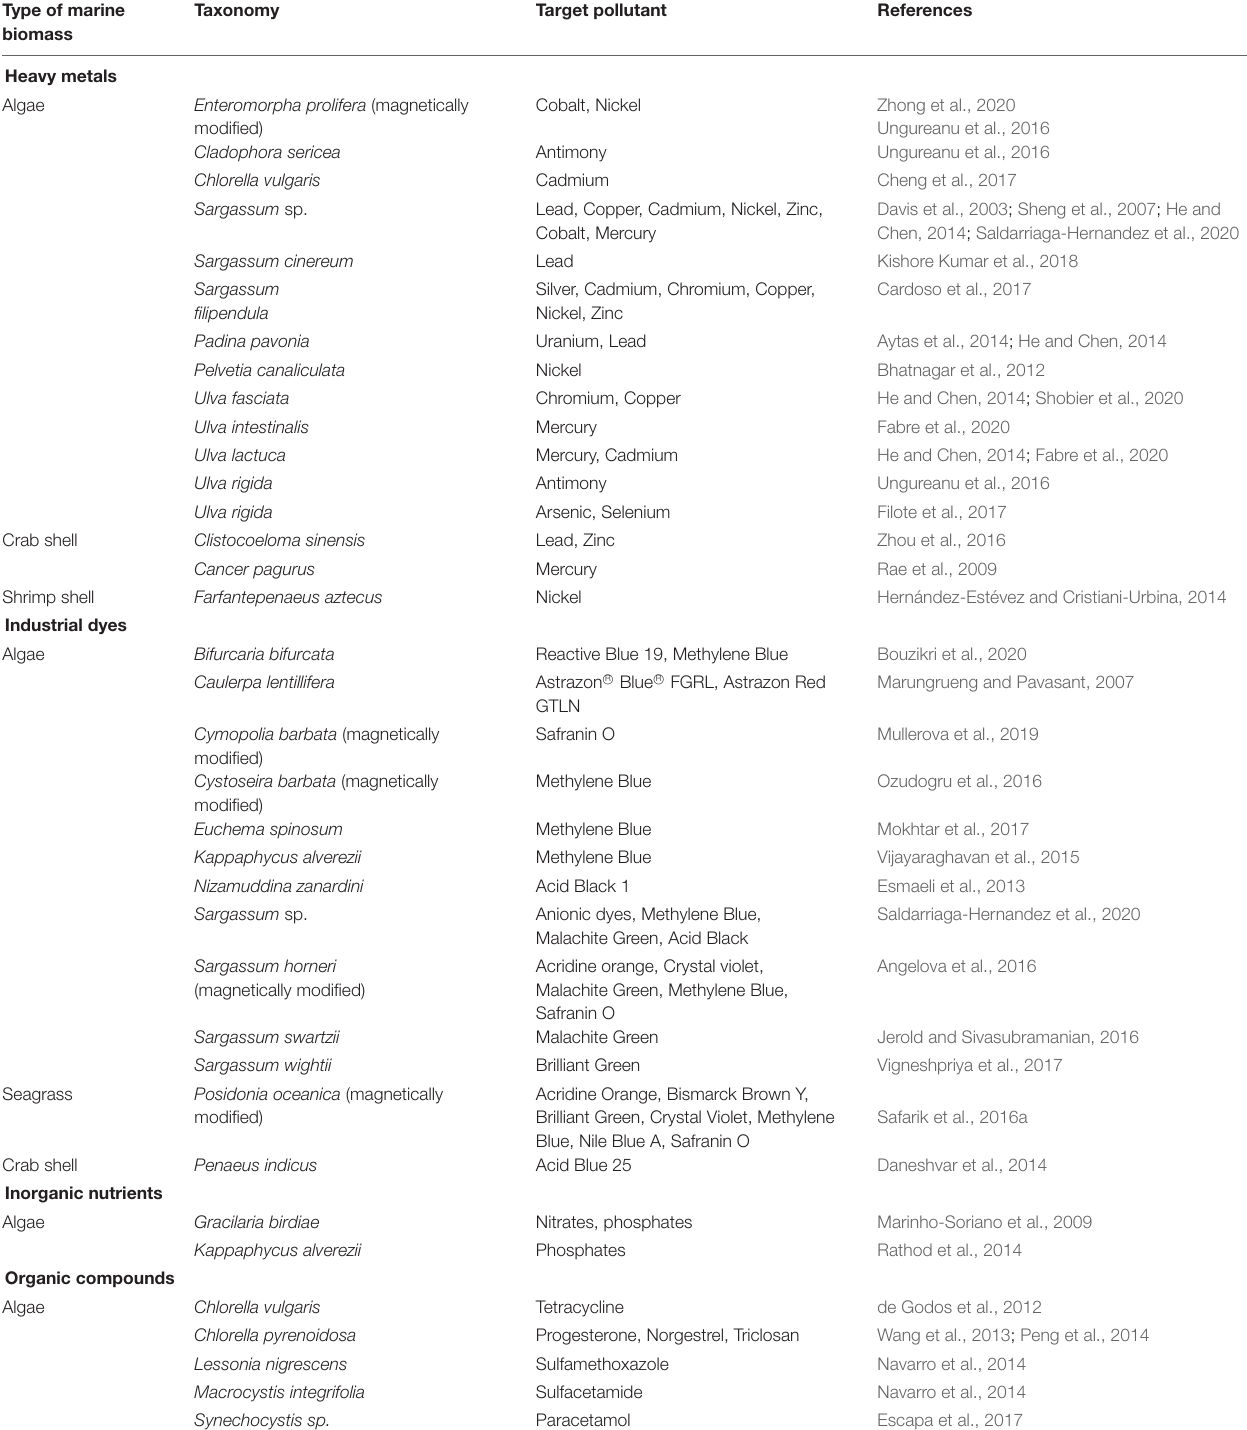
TABLE 1 | Potential of marine biomass to act as biosorbents of organic and inorganic